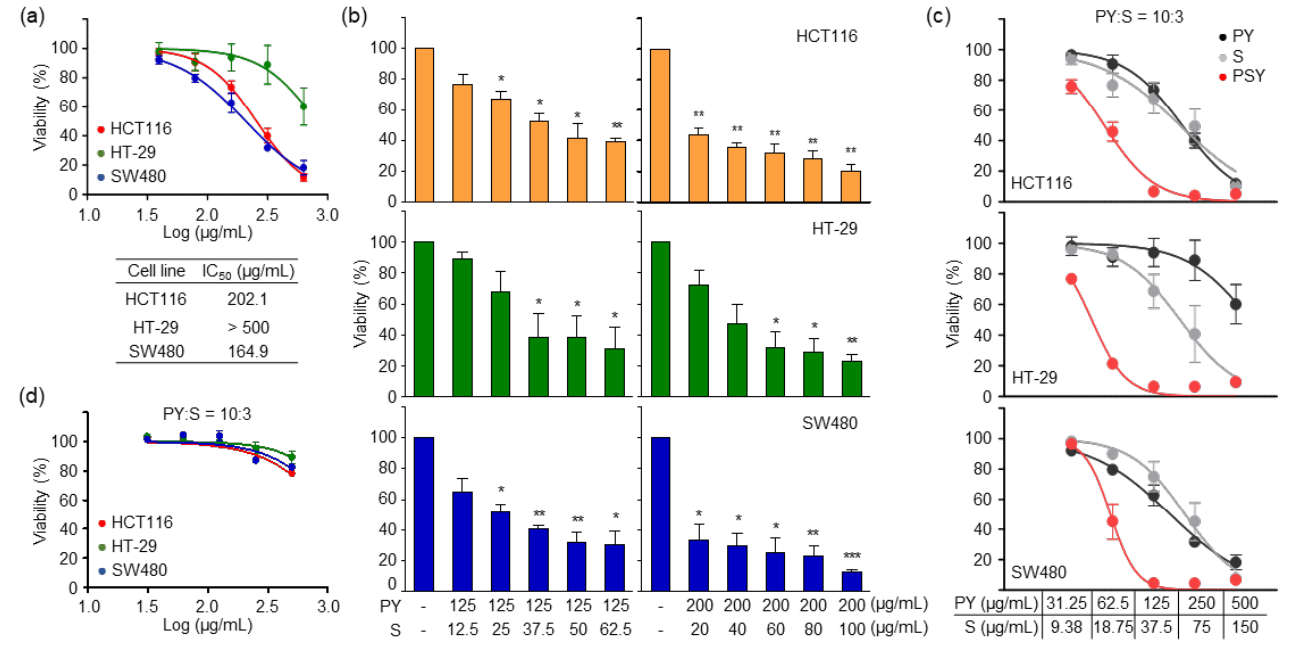
Figure 1. Effects of PSY extracts on the viability of human CRC cells. ( a ) Human CRC cells were treated with ethanol extract (EtOH-Ex) of Patriniae Radix and Coix Seed (PY) for 72 h as indicated. Cell viability was determined by MTT assays. IC 50 values of PY EtOH-Ex in CRC cell lines were determined. ( b ) CRC cells were treated with five concentrations of Mori Cortex Radicis (S) EtOH-Ex in combination with PY EtOH-Ex (125 and 200 μg/mL) for 72 h. The ratio of PY and S was from 10-to-1 to 10-to-5. ( c ) CRC cells were treated with PSY EtOH-Ex in a 10-to-3 combination ratio and compared to each treatment of PY or S EtOH-Ex. ( d ) CRC cells were treated with PSY water extract (Water-Ex) in the combined ratio as indicated. Data are presented as the mean ± standard error of the mean (SEM) of results from at least three independent experiments performed in triplicates. *, p < 0.05, **, p < 0.01, ***, p < 0.001.